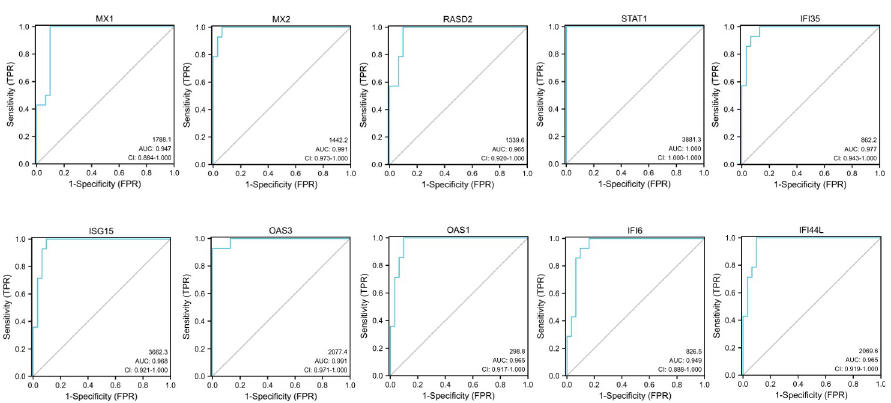
Fig 6. ROC curves of the 10 hub genes constructed by GSE1551 and GSE11971 datasets. The 95% confidence interval (CI), AUC, and predictive variable of each hub genes are shown in the figure.